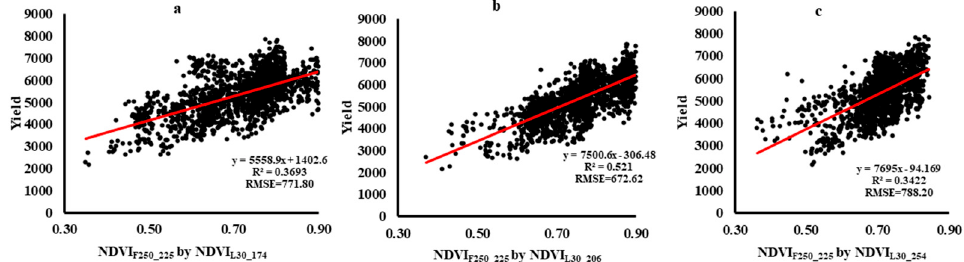
Figure 17. Scatter diagram between fusion result and cotton yield for three plots ( a ) NDVI F250_225 by NDVI L30_174 ; ( b ) NDVI F250_225 by NDVI L30_206 ; ( c ) NDVI F250_225 by NDVI L30_254 .